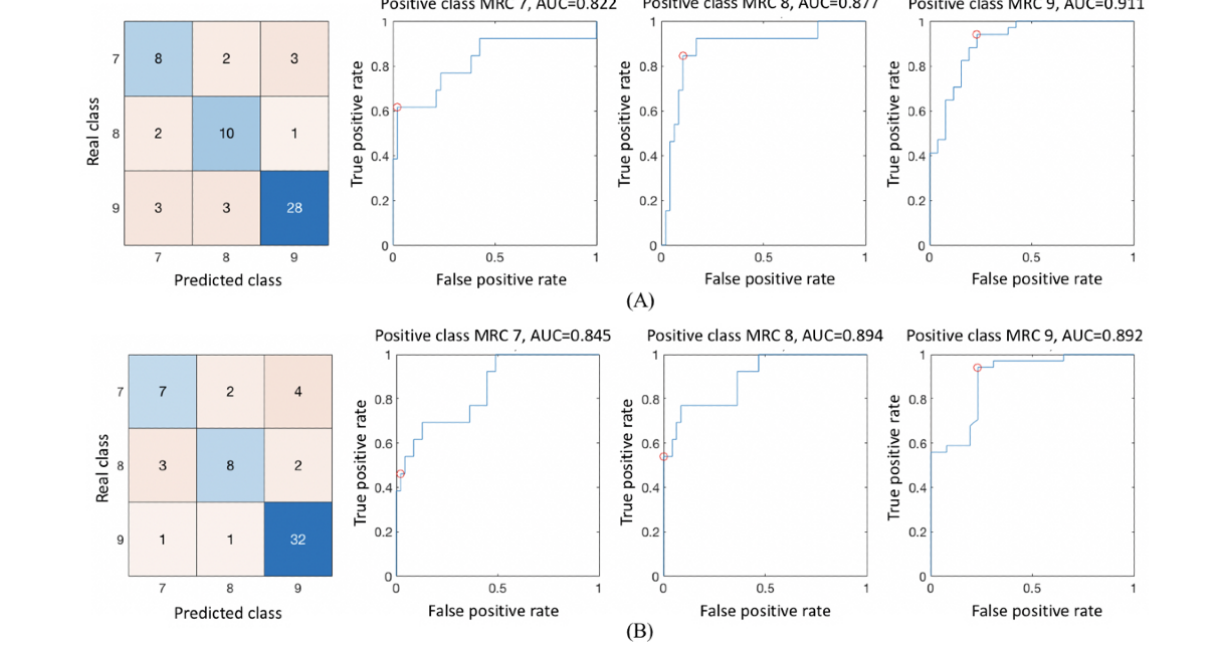
Figure 8. Confusion matrix and receiver operating characteristic of auto-MRC grading using (A) support vector machine and (B) ensemble learning. AUC: area under the receiver operating characteristics curve; MRC: Medical Research Council.